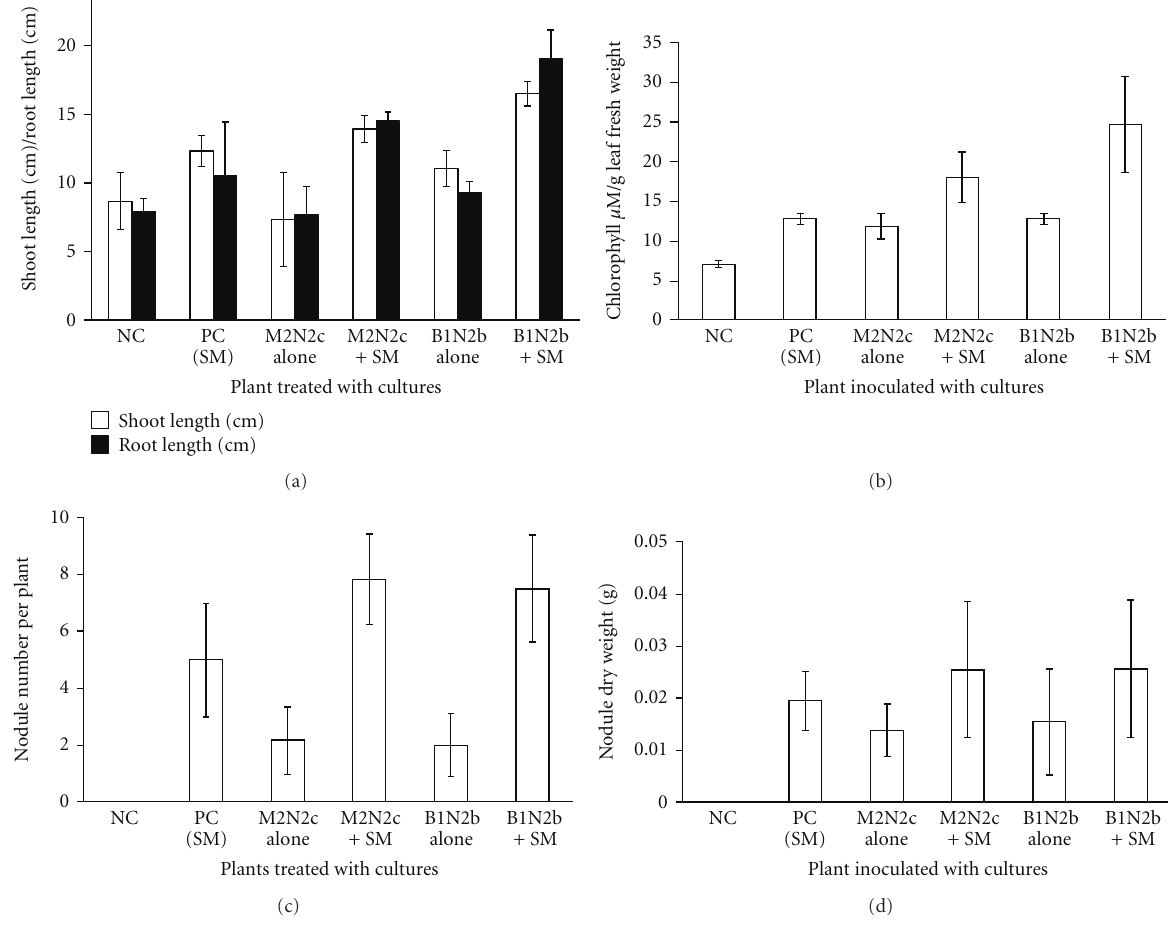
Figure 1: E ff ect of NAB isolates on the shoot length, root length (a), chlorophyll content (b), nodule number (c), and nodule dry weight (d) of the Fenugreek plants when coinoculated with S. meliloti under autoclaved soil conditions. The untreated plants were used as negative control (NC), plants treated with S. meliloti, M2N2c, and B1N2b alone were used as the positive control (PC) and NB control (NABC), respectively. All the treatments were performed in